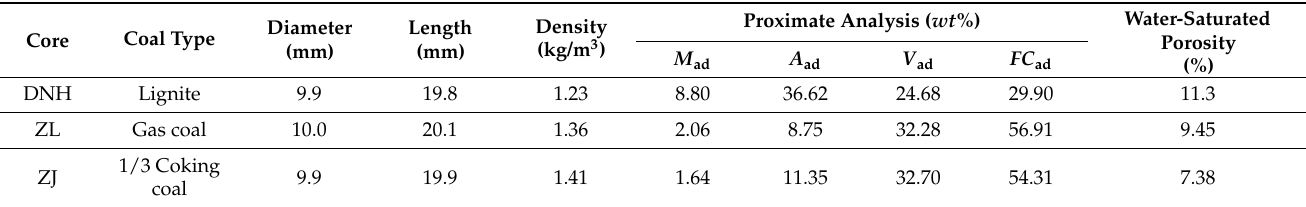
Figure 2. Geographic location and preparation of the three coal cores in this study.